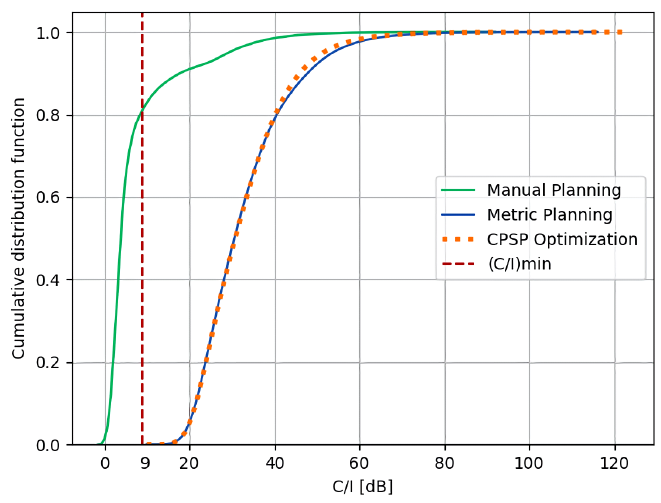
Figure 15. Cumulative distribution function of the C/I within the coverage area of the planned